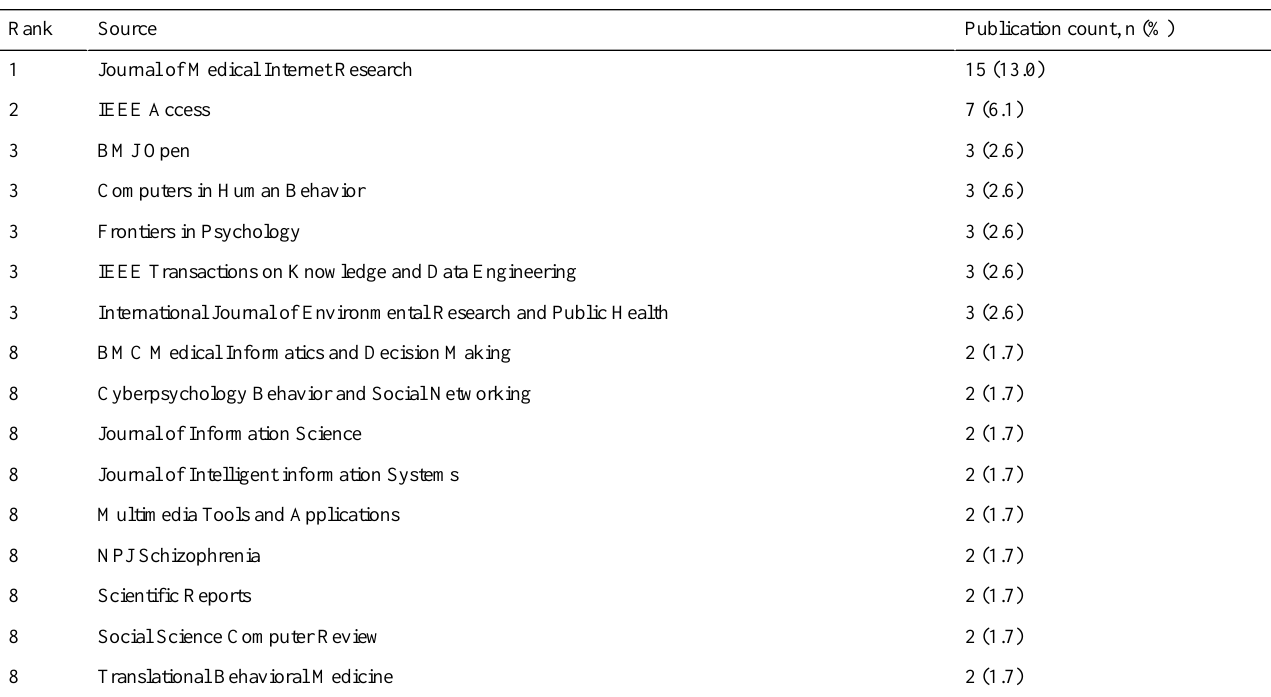
Table 3. Top publication sources in Web of Science